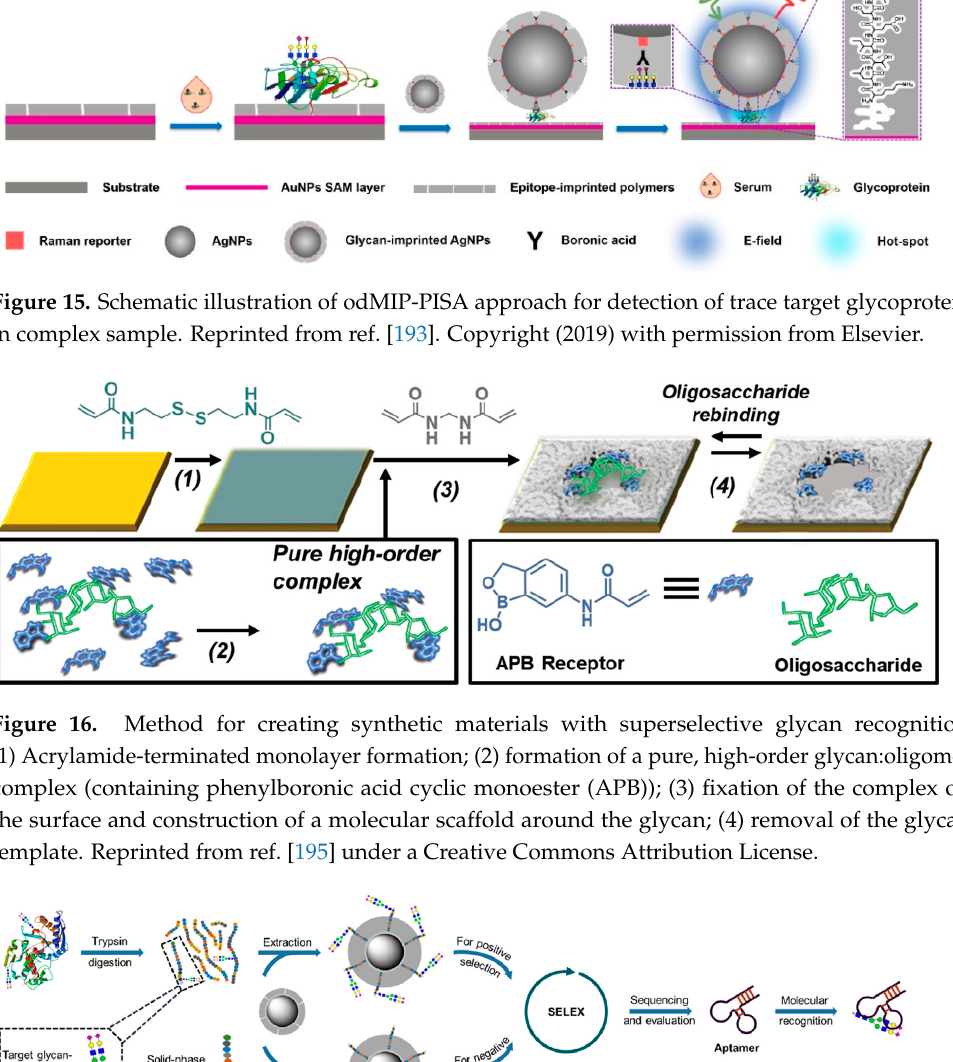
Figure 18. Graphical representation of binding between DNA aptamer recognising glycan part on PSA glycoprotein. hPSA/T-PSAG-1 MD simulation ( a ) Ribbon and stick representations of the hPSA glycoprotein in complex with T-PSAG-1. The structure shown corresponds to a cluster representa- tive from the hPSA/T-PSAG-1 MD trajectory. The sugar residues and specific protein residues (num- bered as in the 3QUM crystal structure) are shown in stick models. The T-PSAG-1 aptamer is shown